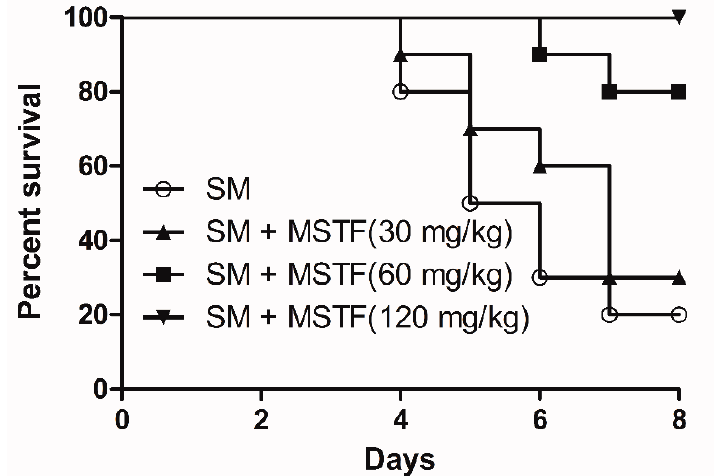
Figure 1. Effect of MSTF (the mixture of SA and TFA) on survival time following sulfur mustard (SM) subcutaneous injection in rats. Survival of rats ( n = 10 per group) treated with MSTF (30, 60 and 120 mg/kg) once each day for seven consecutive days 1 h after 3.5 mg/kg SM treatment. The survival curves were significantly different as predicted by the log rank test ( p =